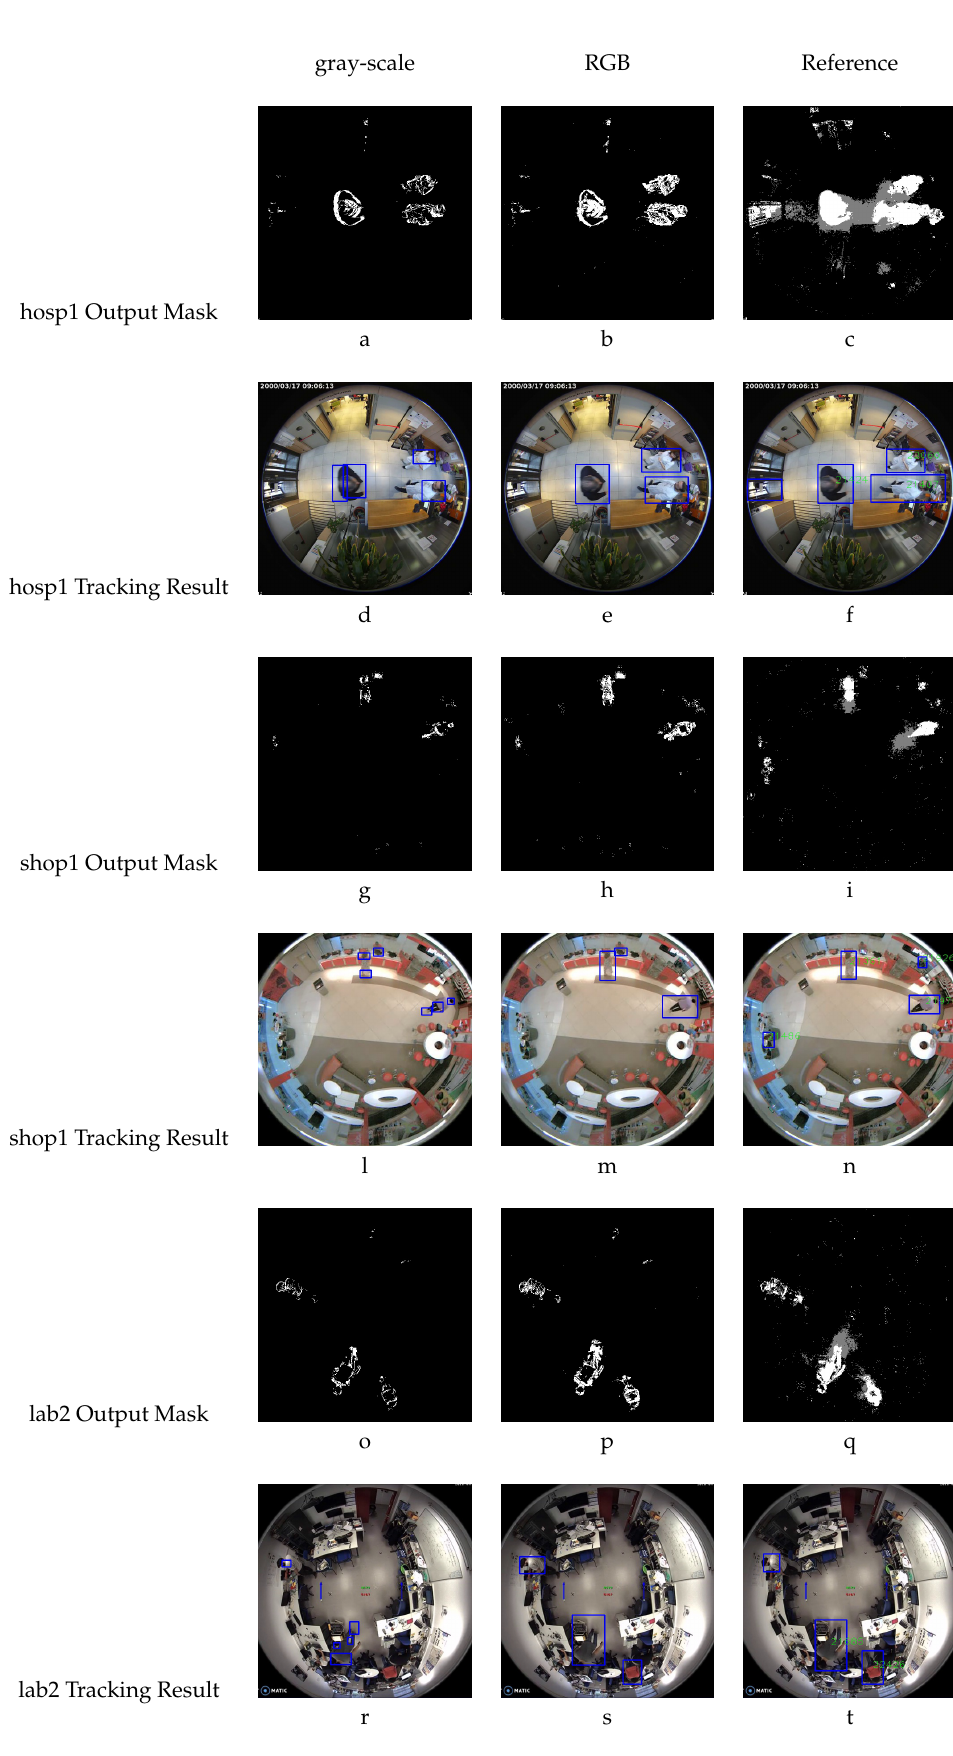
Figure 11. Images comparison ( a – t